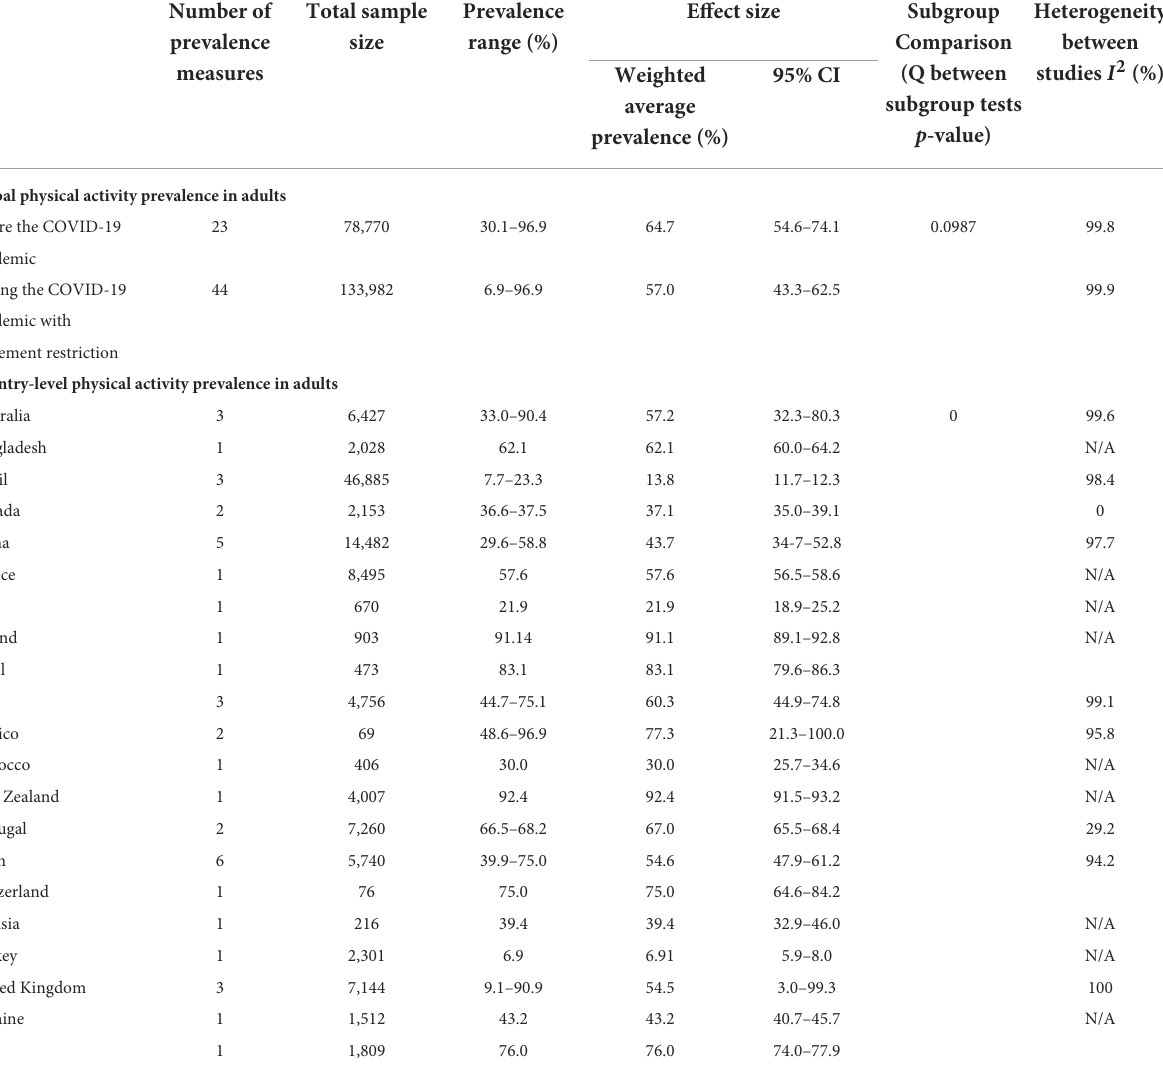
TABLE 1 Pooled prevalence of physical activity in the adult general population.